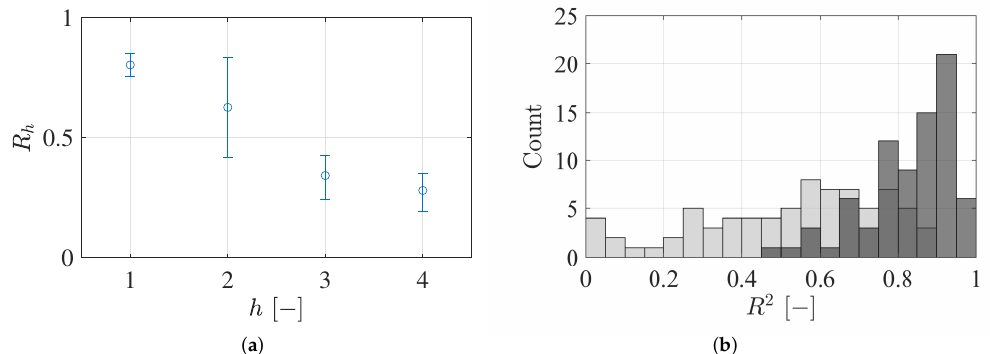
Figure 5. ( a ) R h for the first four harmonics: mean value ( ◦ ) and error bar indicating the ( P 25 − P 75 ) interval; ( b ) Histogram of the coefficients of determination for the time domain ( R 2 frequency domain ( R 2 , f